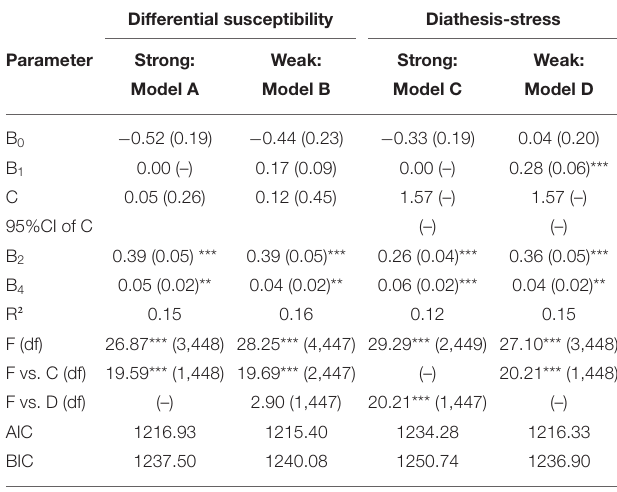
TABLE 6 | Results for re-parameterized regression model for